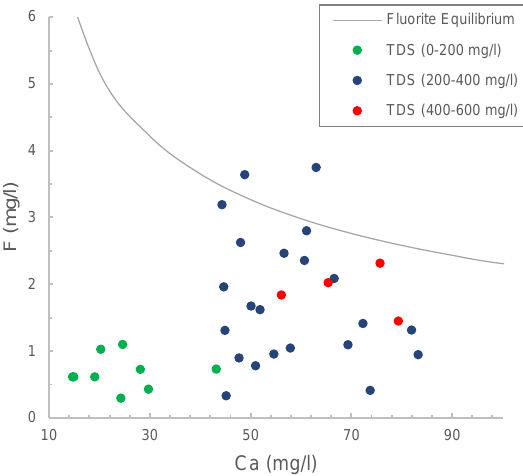
Figure5. Plotofcalciumversusfluorideshowingequilibriumforthemineralfluorite(CaF 2 ). Thefluorite equilibrium curve was calculated from {F} = ( K eq / {Ca} ) 0.5 that assumes equality of the ion activity product (IAP) with the equilibrium constant ( K eq ) (3.7 × 10 − 11 ).